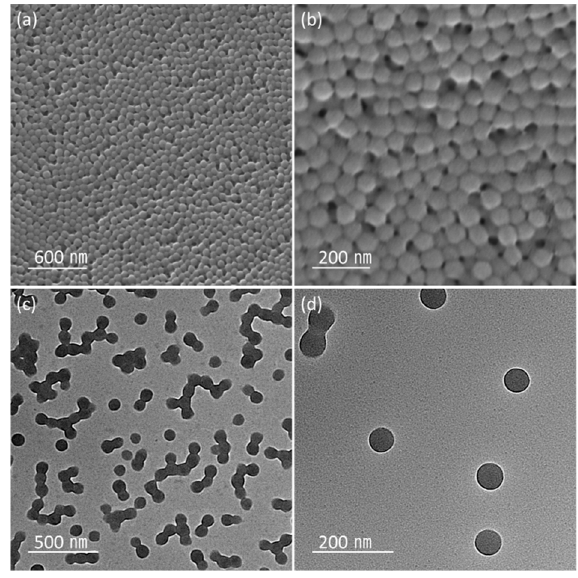
Figure 1. ( a , b ) SEM and ( c , d ) TEM images of n-octadecane/poly(methylmethacrylate) (PMMA) nanobeads.